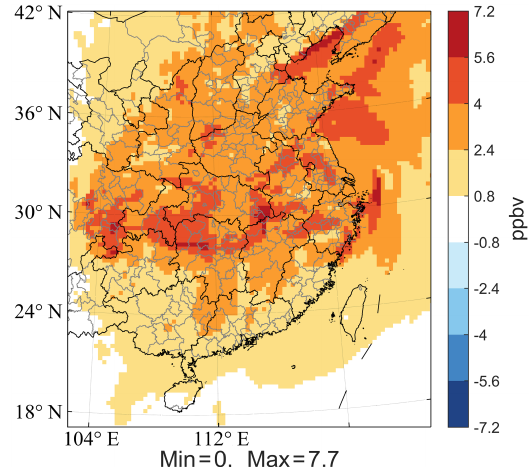
Figure 9. Spatial distribution of the maximum impact of chlorine emissions on 1h O 3 concentration in November